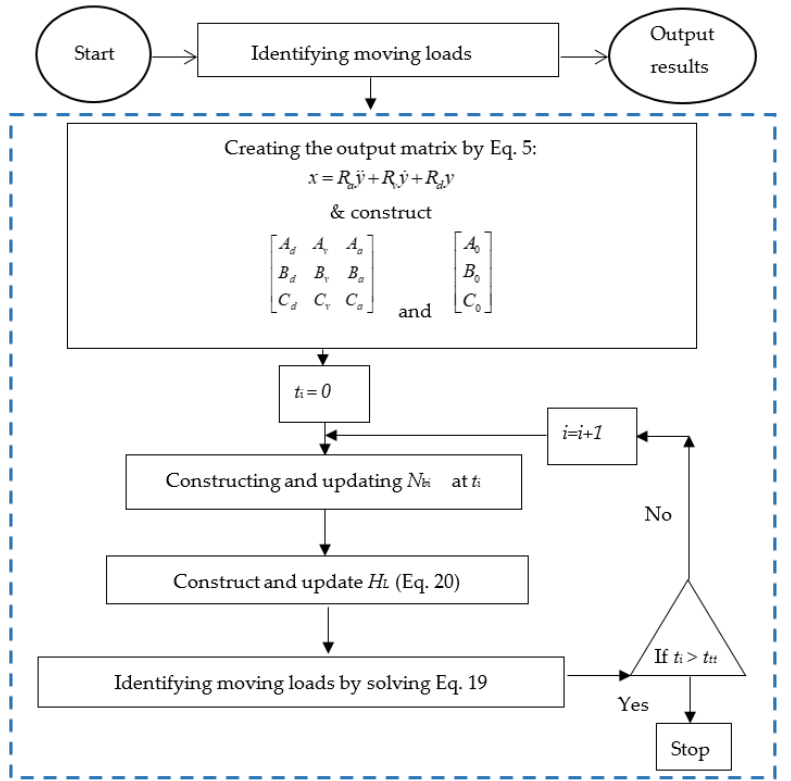
Figure 4. Moving load identification by the explicit form of Newmark- β method